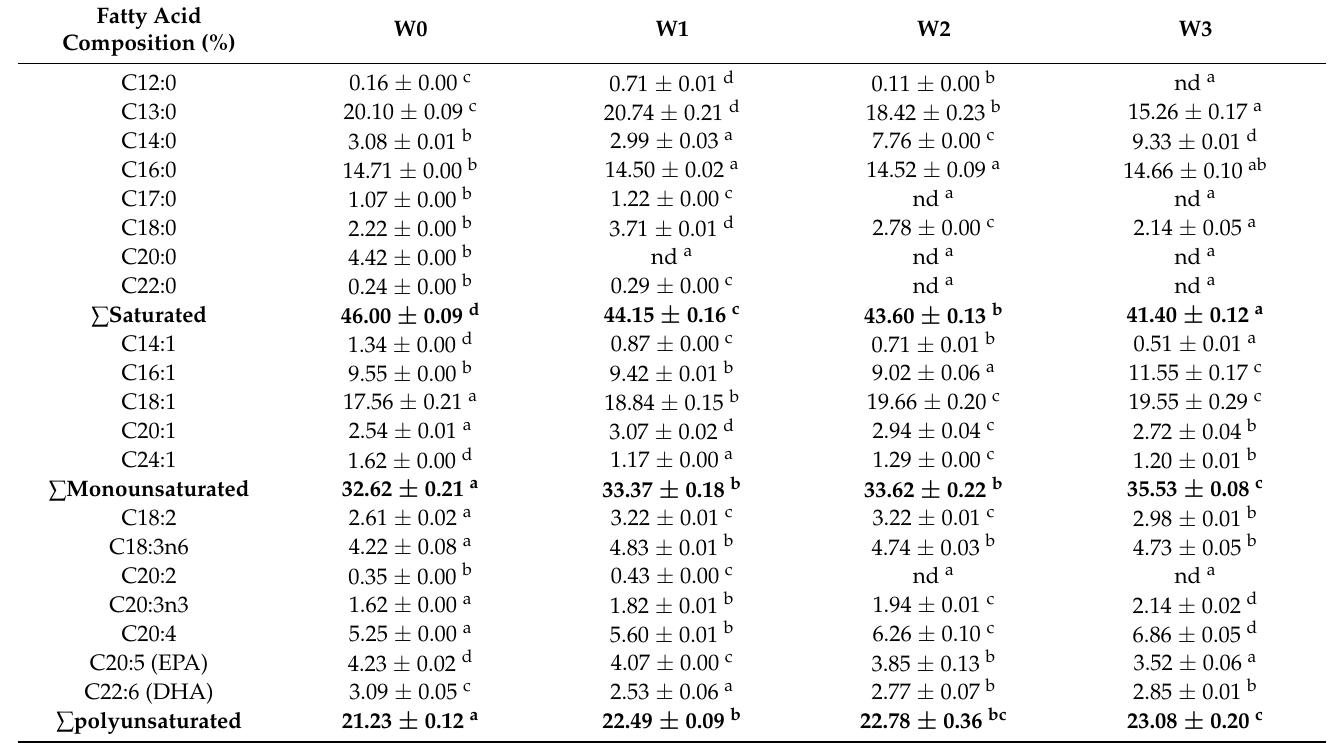
Table 2. Fatty acid composition of surimi with different washing times.